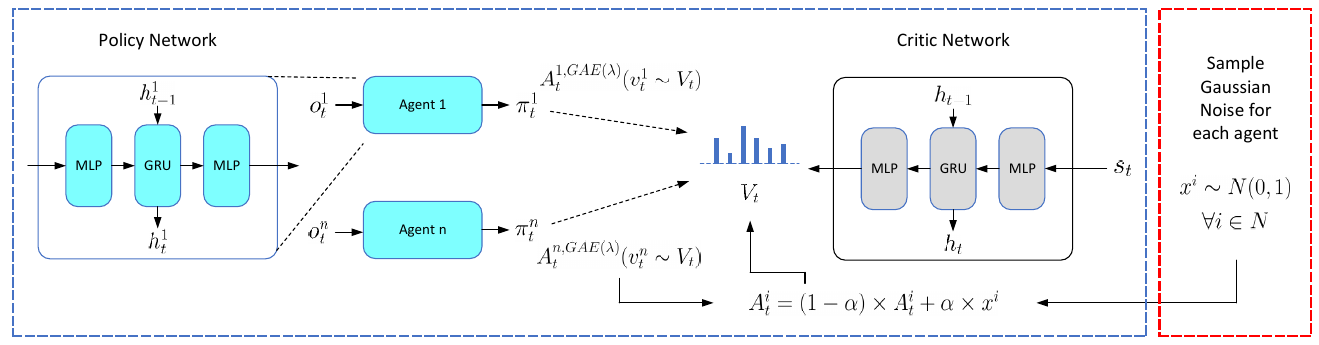
Figure 2. The framework of NA-MAPPO, blue-dash line region refers to the outline of MAPPO, red-dash line region refers to the designed Gaussian noise injected into the centralized critic